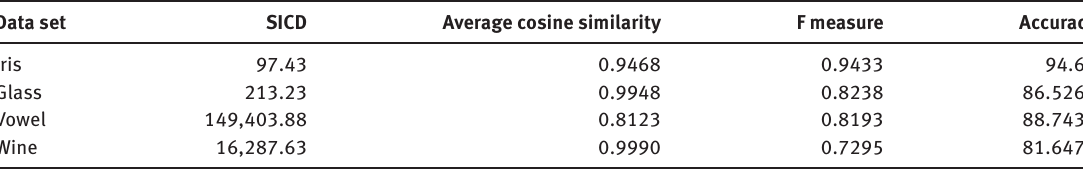
Table 2: SSO Clustering.